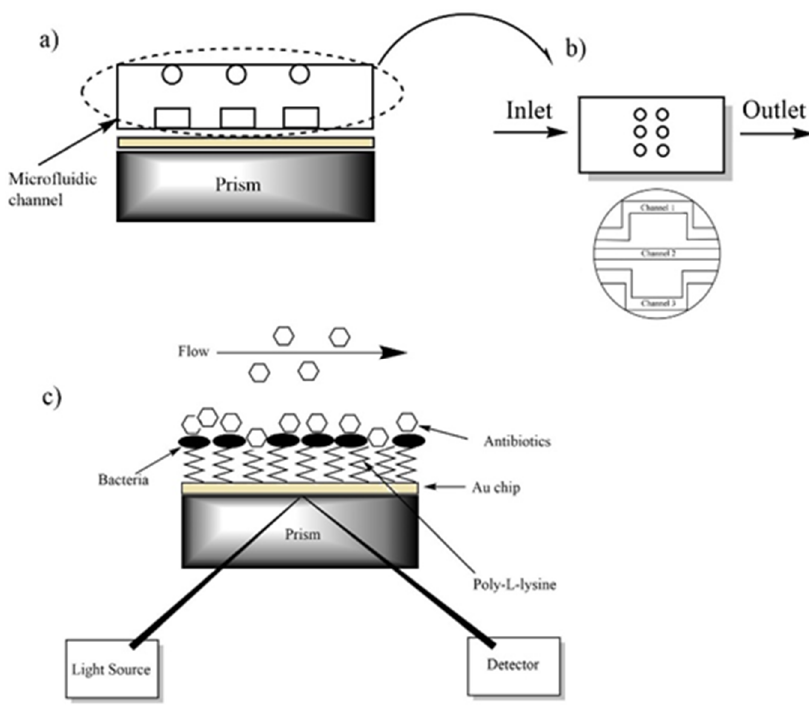
Figure 1. A scheme of the SPR system. ( a ) Illustration of the multiple microfluidic integrated SPR platform. ( b ) The top and bottom appearance of a microfluidic cell chamber. ( c ) Protocol for the antimicrobial test of bacteria.